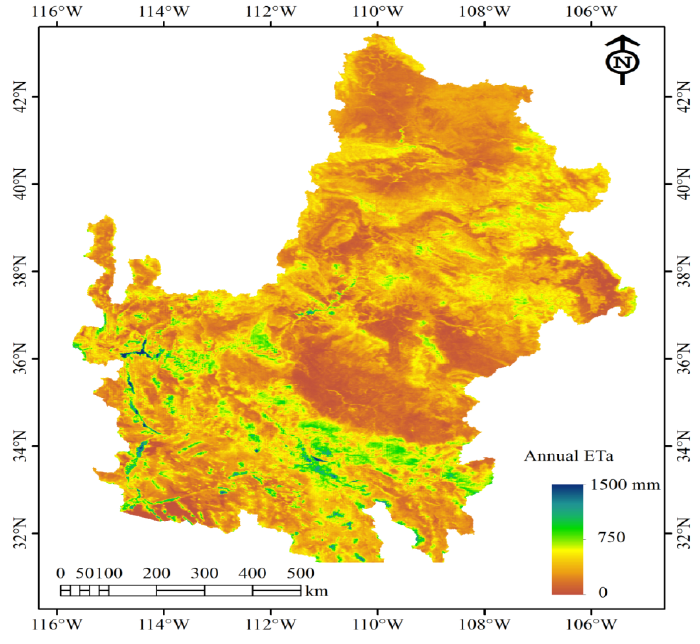
Figure 9. Spatial distribution of evapotranspiration in the Colorado River Basin for 2010 using MODIS